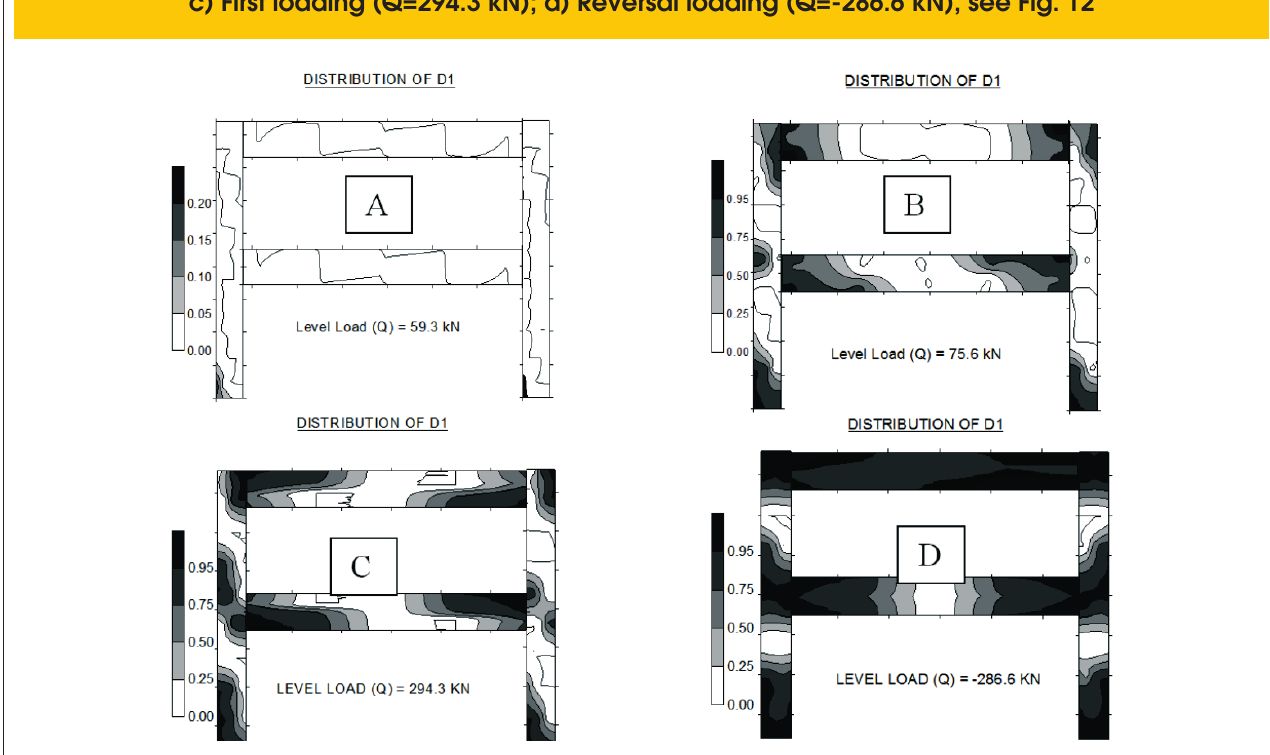
Figure 14 – D damage distribution: a) First loading (Q=59.3 kN); b) First loading (Q=75.6 kN);